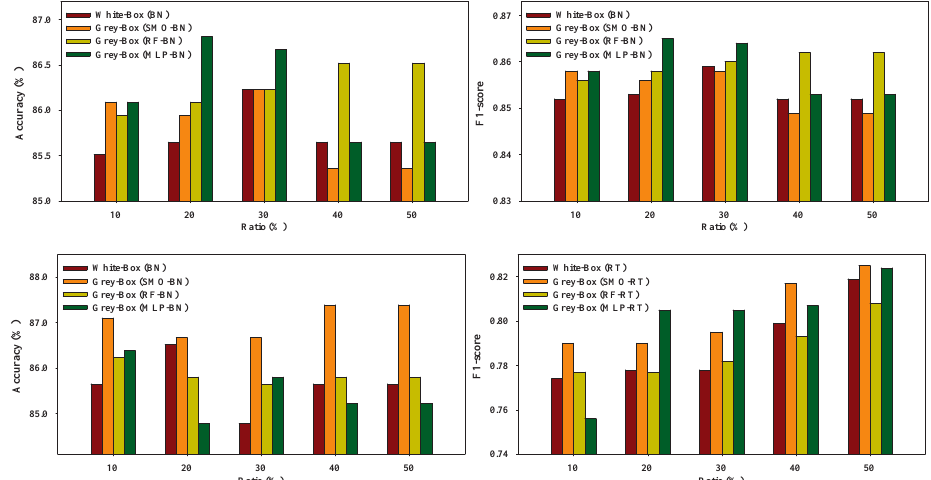
Figure 5. Box-plot with performance evaluation of Grey-Box and White-Box models for Australian dataset.